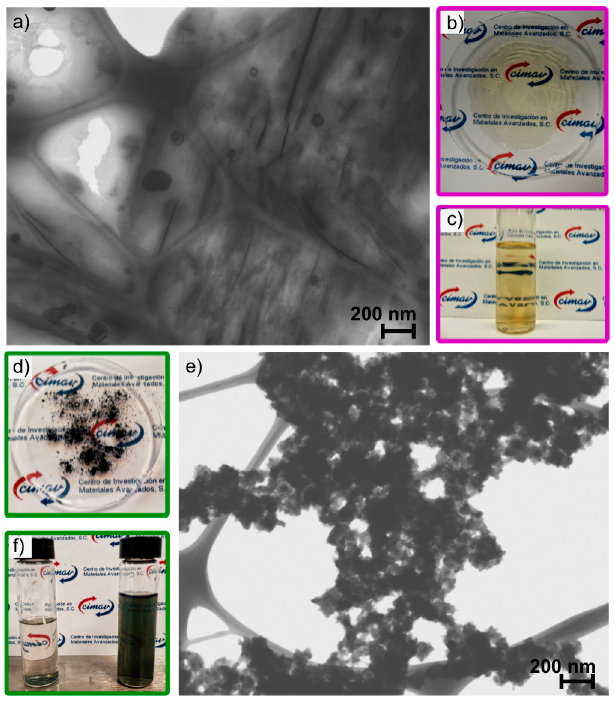
Figure 10. ( a ) Morphology, ( b ) solid phase, and ( c ) water solution of Poly(Ani-AMPS), and ( d ) solid phase, ( e ) morphology, and ( f ) sediment (left) and dispersion (right) in water of PAni-AMPS.